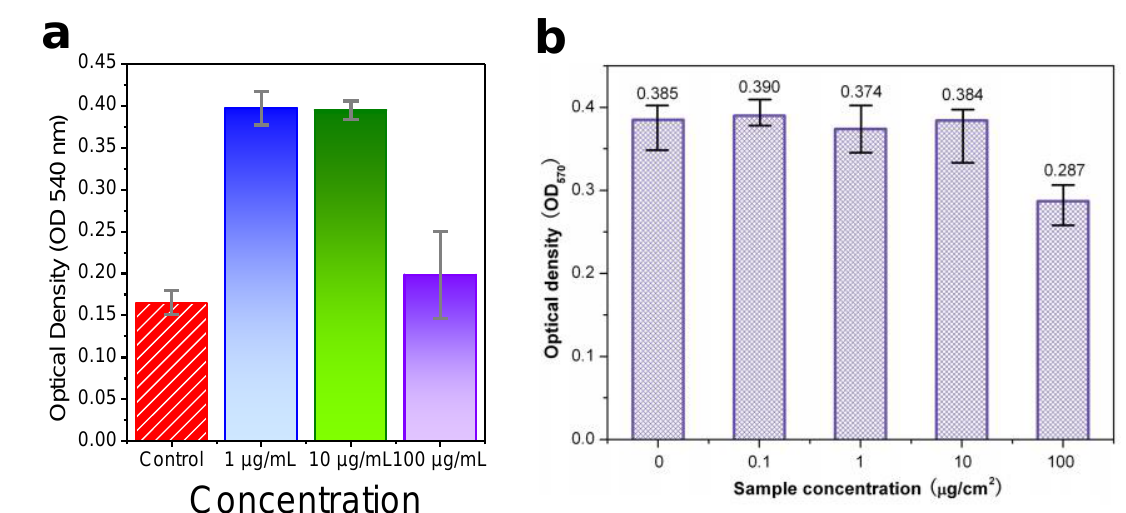
Figure 10. Evaluation of cytotoxicity. ( a ) MTT assay-the HeLa cells were incubated with a 1, 10, and 100 µg/mL concentra- tions of ZnAl 2 O 4 for 24 h, and a control was also evaluated for ZnAl 2 O 4 : nanofibers doped with Nd and co-doped with Ce. ( b ) Cytotoxicity among the various concentrations 1–100 µg/cm -2 . Reprinted with permission from [41] . Copyright 2013, American Scientific Publishers.